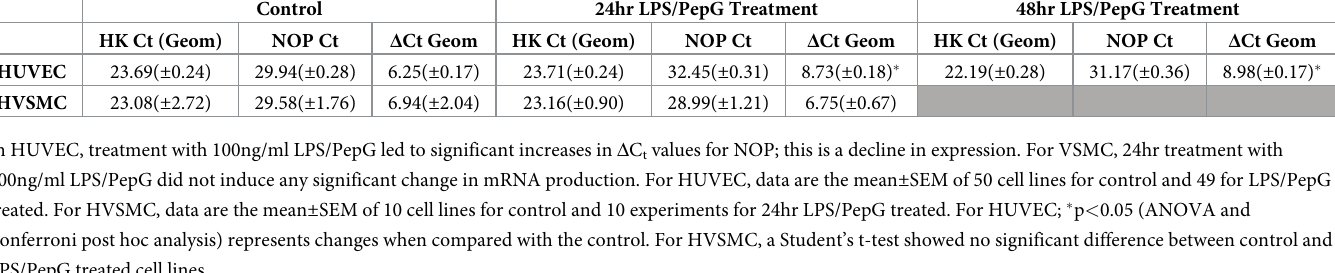
Table 1. NOP mRNA from HUVEC and HVSMC was measured in qPCR experiments relative to two housekeeper genes, B2M and either EFL2B1 (HUVEC) or ELF1 (HVSMC), to determine Δ C t relative to the housekeeper geometric mean. Control 24hr LPS/PepG Treatment 48hr LPS/PepG